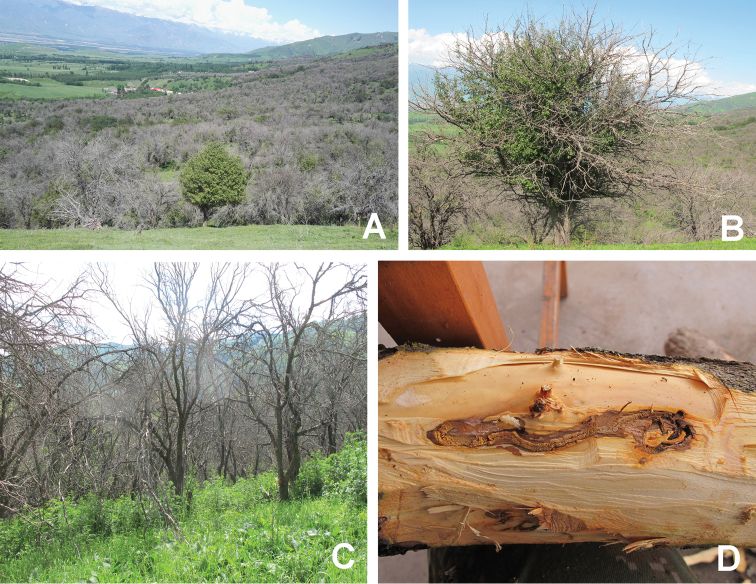
A Trees of Malus
sieversii damaged by A.
maliB A single tree of Malus
sieversii damaged by A.
maliC Dead branches because of A.
maliD Trunk of Malus
sieversii damaged by A.
mali.